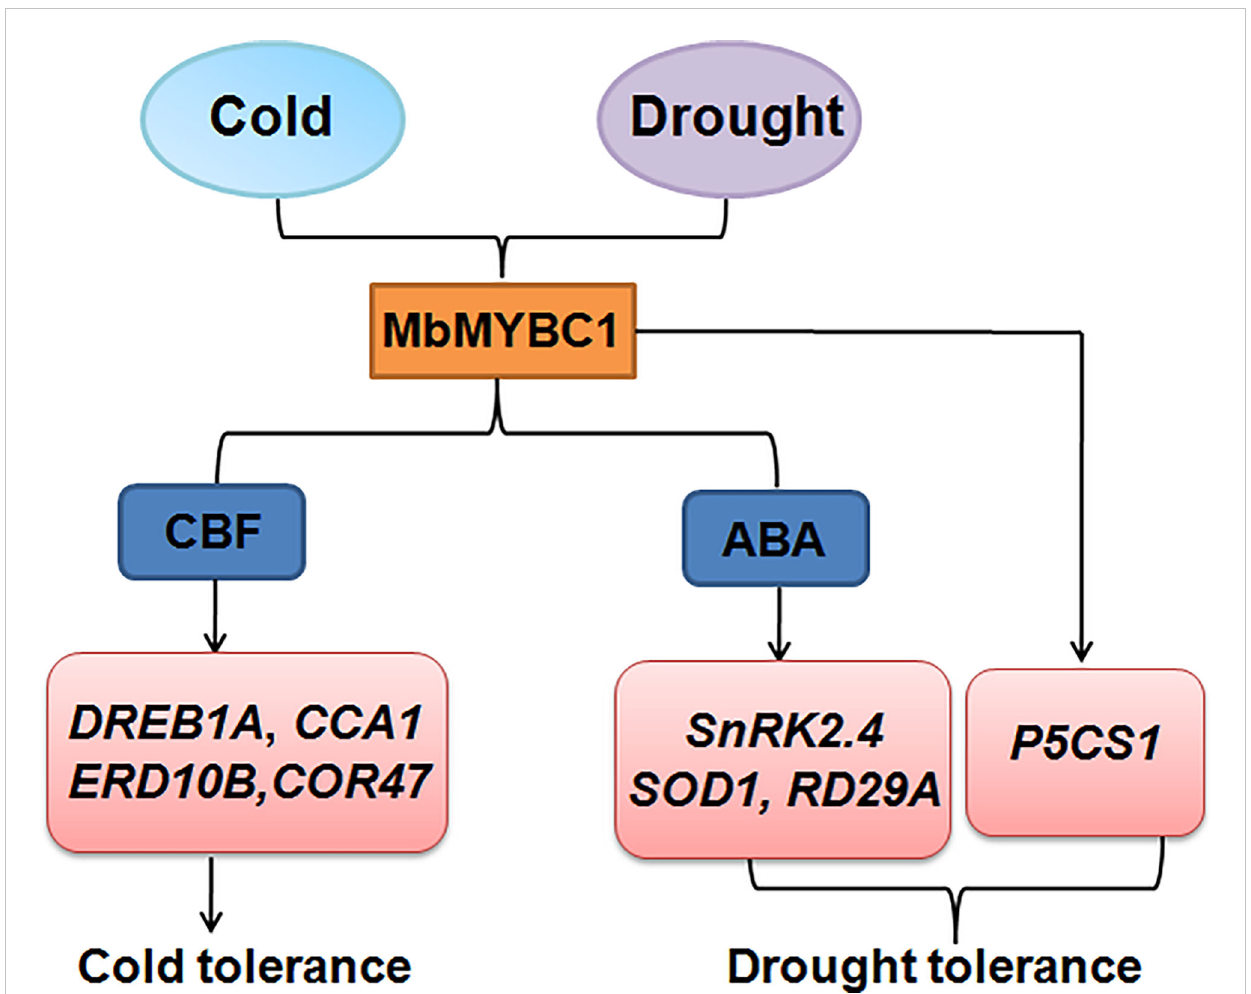
FIGURE 11 A potential model of MbMYBC1 regulating plant responses to low temperature and drought